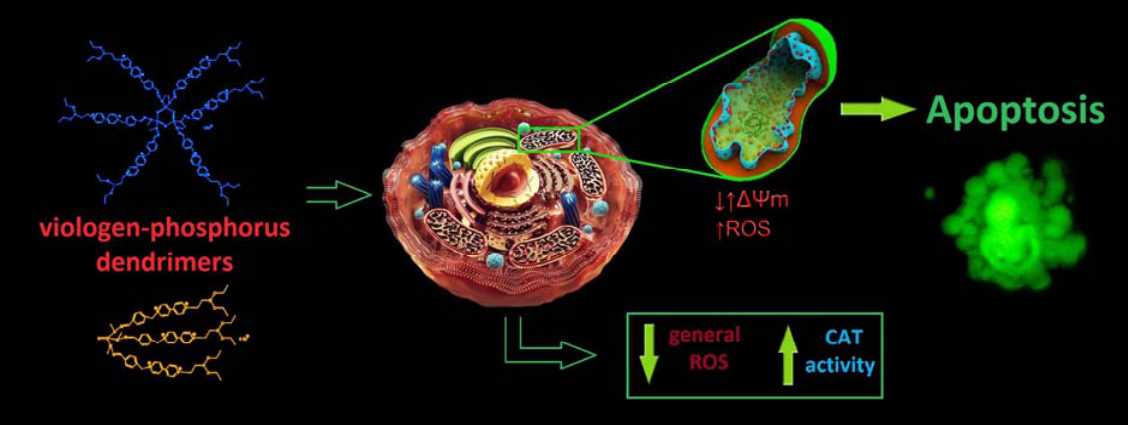
Figure 10. A schematic representation of the mechanism of action of VPDs on mHippoE-18